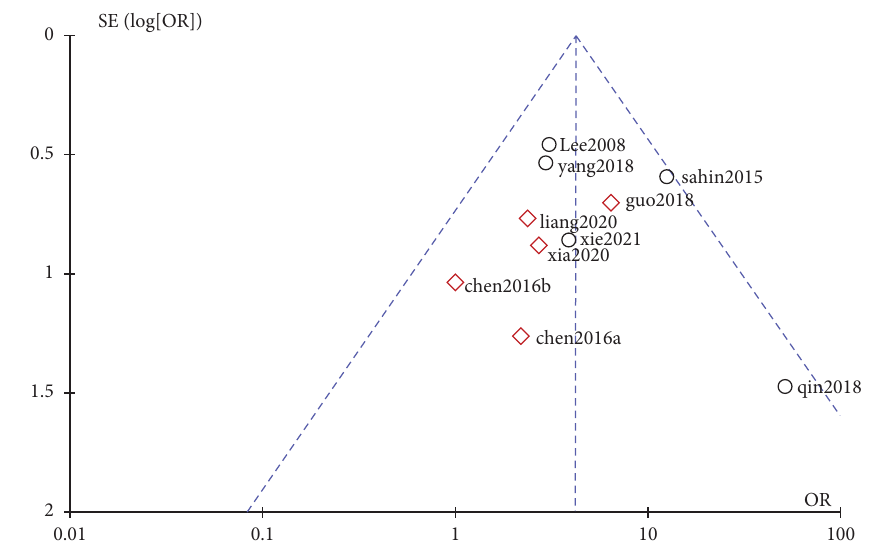
Figure 3: Publication bias of included